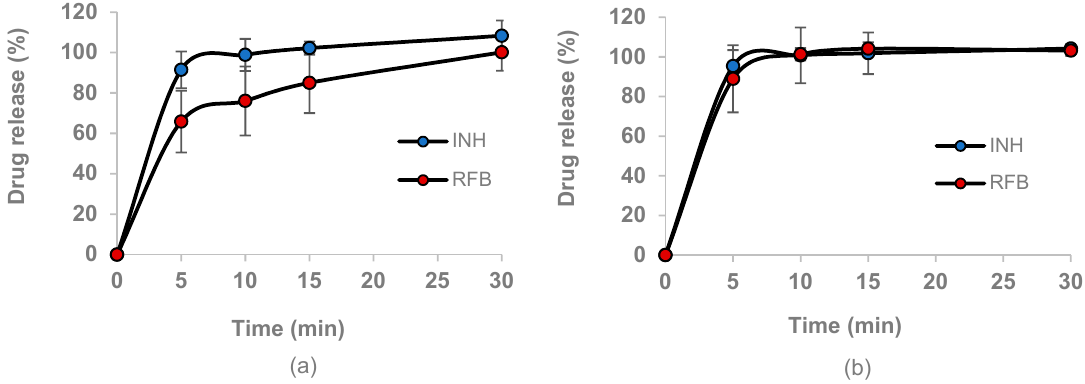
Figure 4. In vitro release profile of isoniazid (INH) and rifabutin (RFB) from FUC/INH/RFB (10/1/0.5, w / w ) in ( a ) PBS pH 7.4-Tween 80 ® and ( b ) acidic medium pH 5.0-Tween 80 ® . FUC: fucoidan; mean ± SD, n = 3.